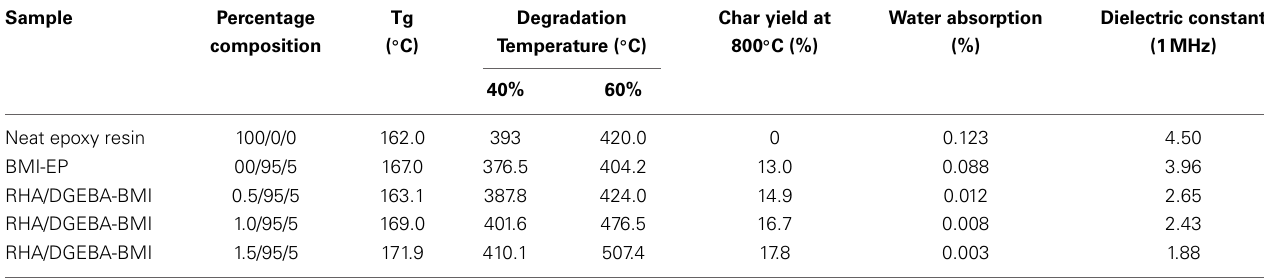
Table 1 | Thermal properties of neat epoxy and RHA/DGEBA-BMI nanocomposites.